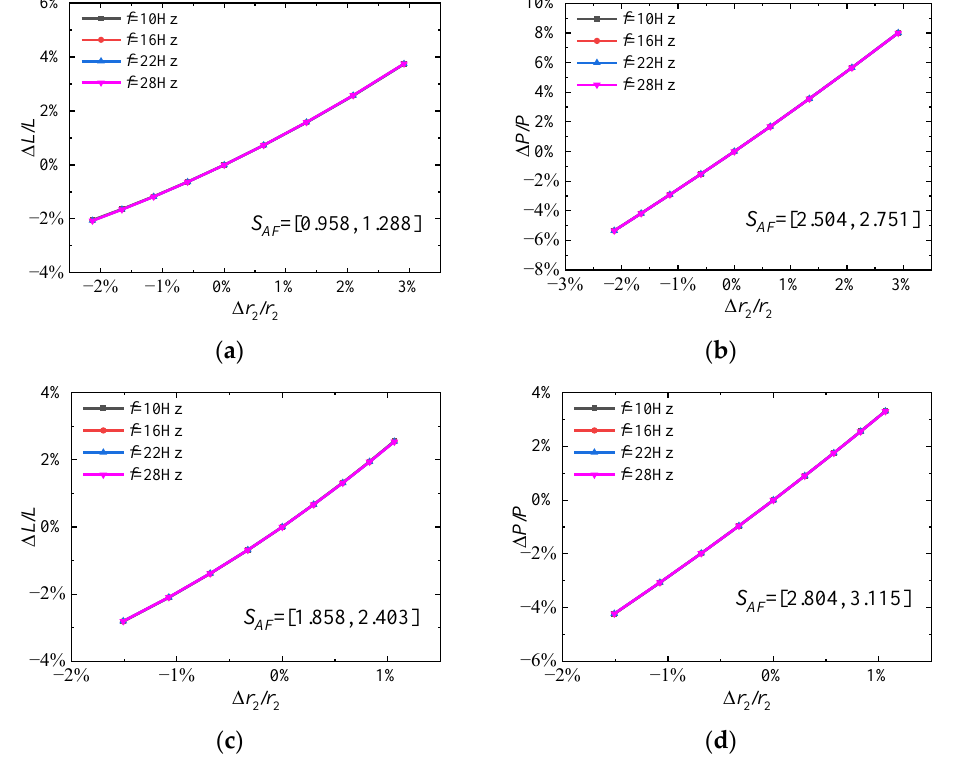
Figure 10. Sensitivity analysis for the dimensionless radius of the second moment of area r 2 by modulating the value of c max at different spanwise locations. ( a ) Variation of lift vs. variation of r 2 , modulating c max at 0.25 R . ( b ) Variation of aerodynamic power vs. variation of r 2 , modulating c max at 0.25 R . ( c ) Variation of lift vs. variation of r 2 , modulating c max at 0.75 R . ( d ) Variation of aerodynamic power vs. variation of r 2 , modulating c max at 0.75 R .